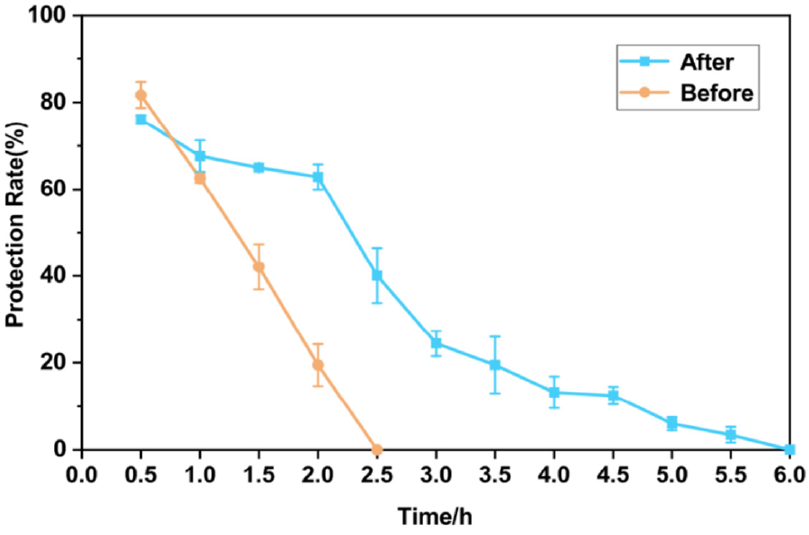
Figure 7. The comparison of the MGS release before and after embedding in gastric and intestinal